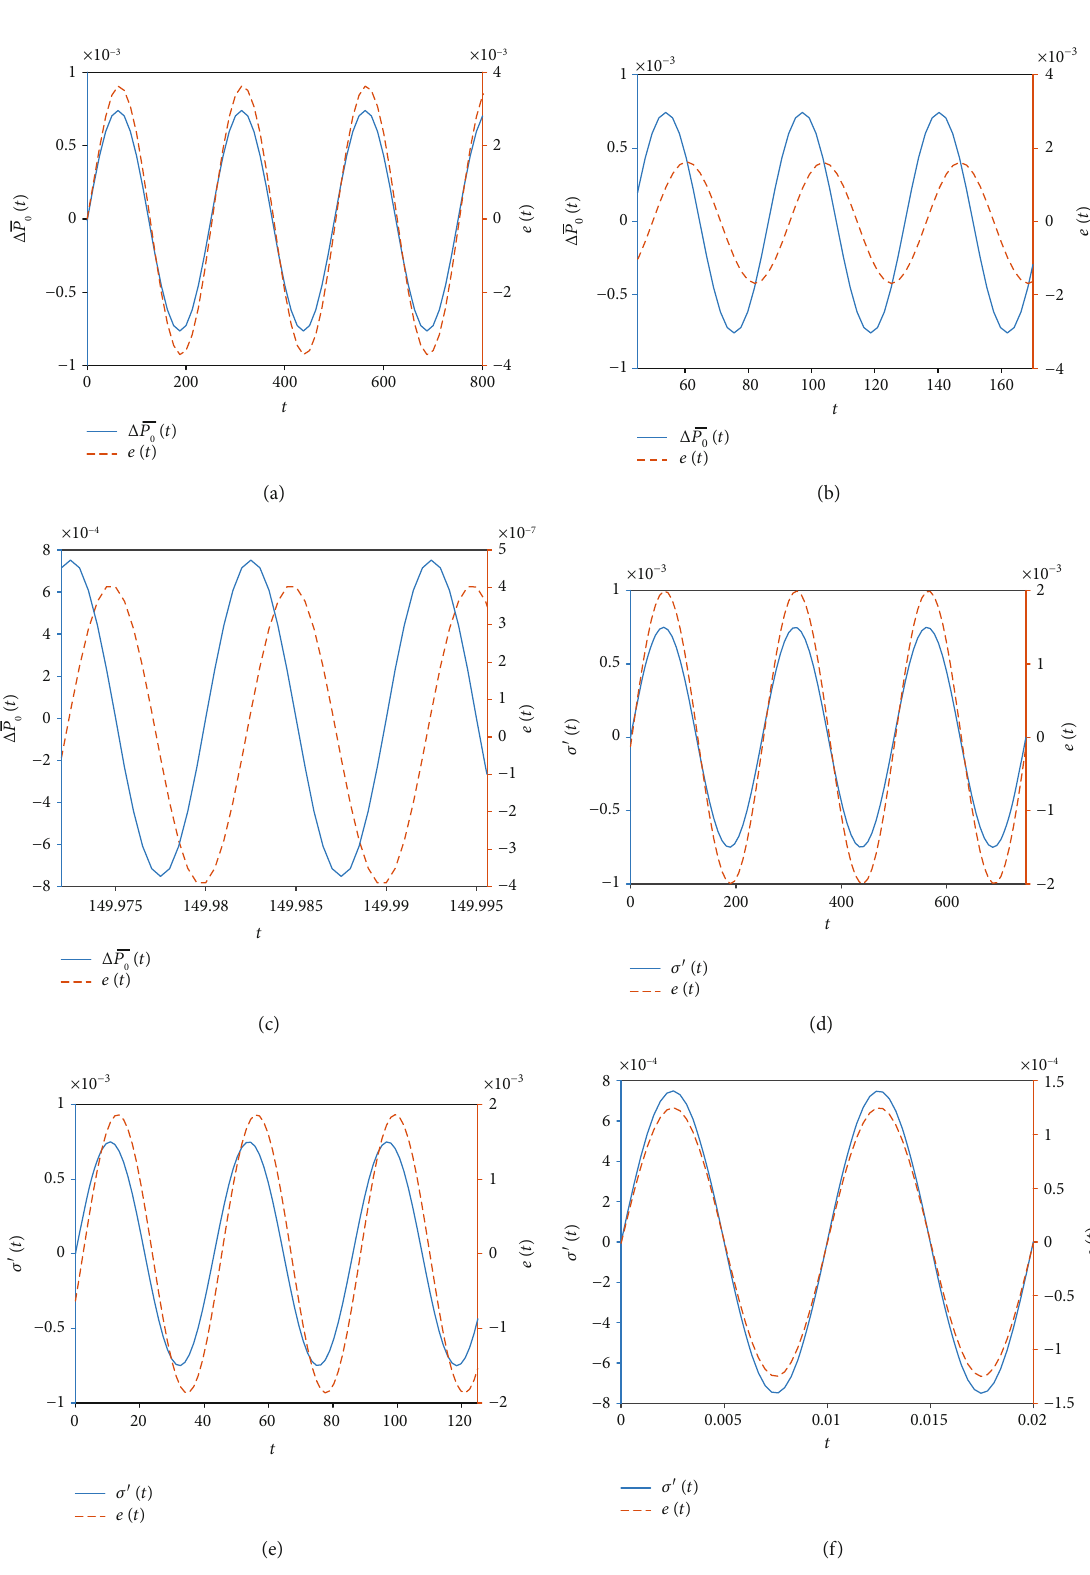
ð t Þ (solid line on y -axis) and strain response e ð t Þ 0 j = 0 : 2600 , ϵ = 0 ′ = 0 : 00075 , K = 0 : 3750 , and τ = 1 : 6670 A